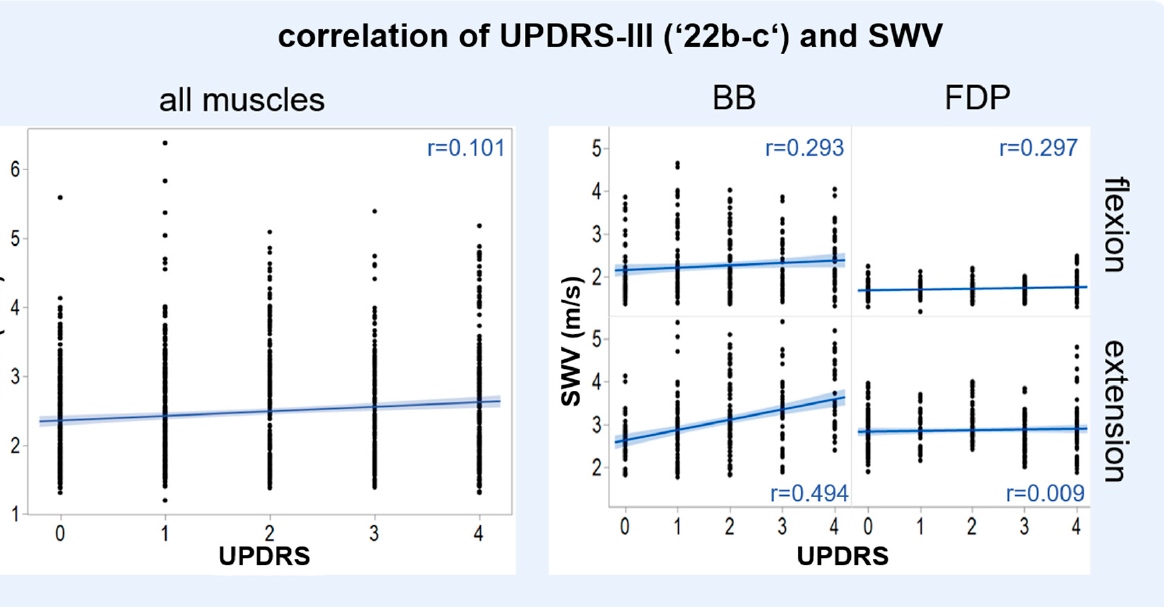
Figure 3. ( Left ): Overall Spearman’s Rho correlation (r) analysis of the Movement Disorder Society Unified Parkinson’s Disease Rating Scale (MDS-UPDRS) with shear wave velocity (SWV) for all Parkinson’s patients and muscles (biceps brachii and flexor digitorum profundus muscle). A significant positive correlation (r = 0.1, p < 0.001) between MDS-UPDRS III item 22b–c and SWE can be seen. ( Right ): Spearman’s Rho correlation (r) analysis of MDS-UPDRS with SWV for all Parkinson’s patients. Correlations were divided into muscle groups (biceps brachii and flexor digitorum profundus) and position (extension or flexion). A correlation of r = 0.494, p < 0.001 was seen for the biceps muscle in extension.